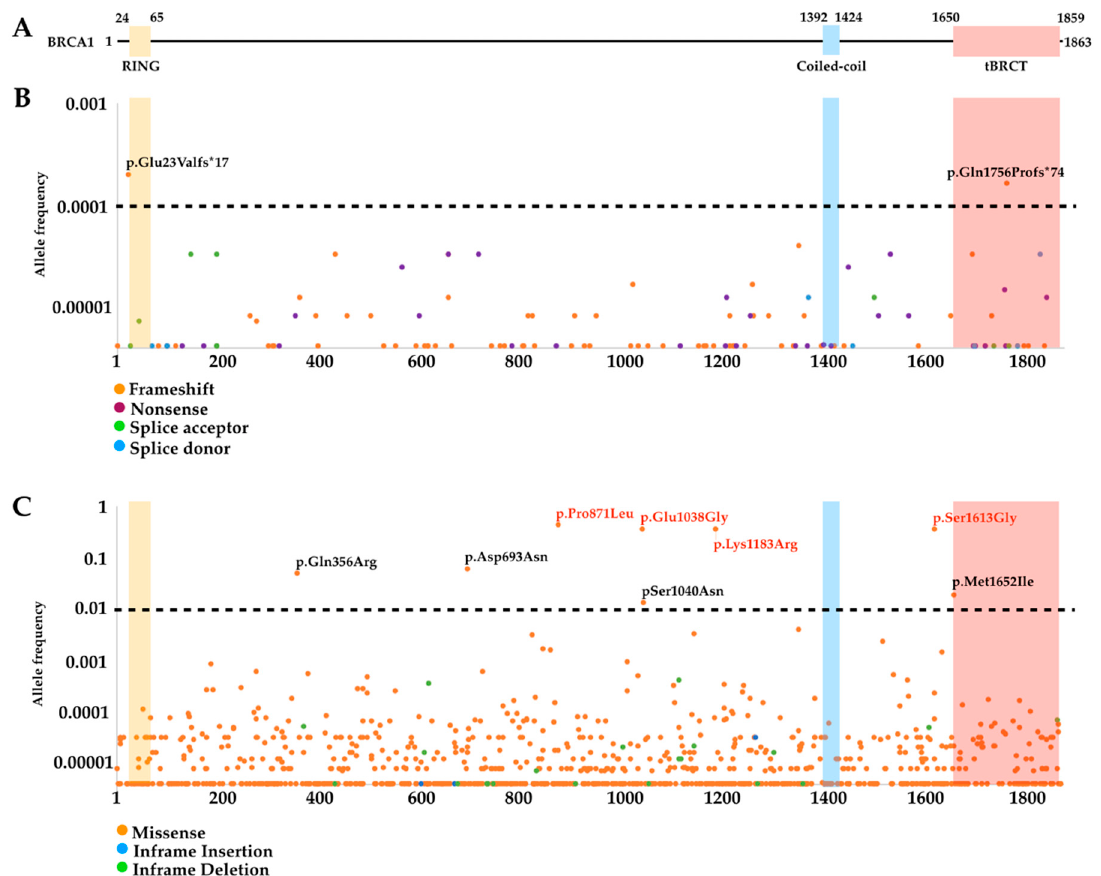
Figure 3. BRCA1 allele frequency. ( A ) Diagram of BRCA1 showing the RING-finger, coiled-coil and tandem (tBRCT) domains represented by the yellow, blue and pink backgrounds respectively. ( B , C ) Graphic representation of the allele frequency of BRCA1 (Ensembl transcript ENST00000357654.7) germline variants (HGVS nomenclature) deposited on the genome aggregation database (gnomAD) with data for individuals not selected for family or personal history of cancer [72] showing ( B ) frame shift (orange), nonsense (purple), splice acceptor (green) and donor (blue) variants; or ( C ) missense (orange), in frame insertion (blue) and deletion (green) variants.